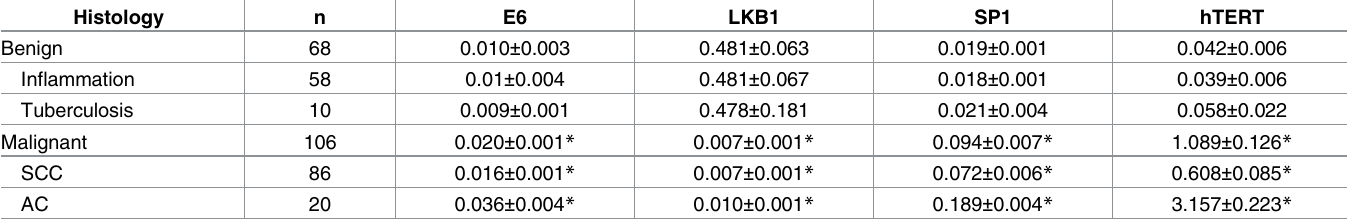
Table 1. The mRNA of E6, LKB1, Sp1 and hTERT with qRT-PCR in bronchial brushing cells of patients with benign and malignant lung lesions (Mean ± SEM).